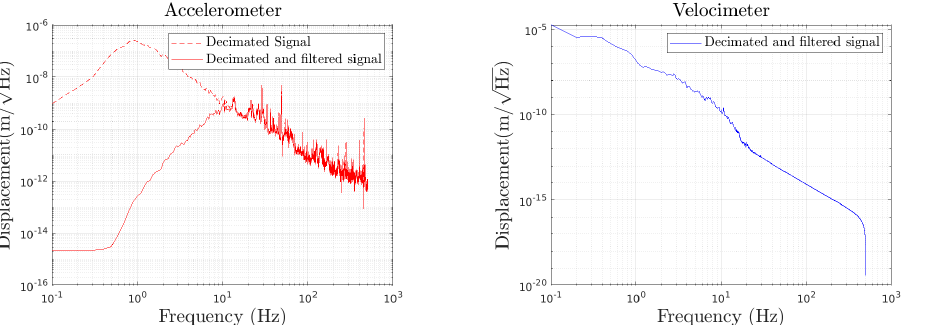
Figure 8. The displacement of the cryobaffle is obtained by merging data from an accelerometer for frequencies above 10 Hz ( left ) with data from a velocimeter for frequencies below 10 Hz ( right